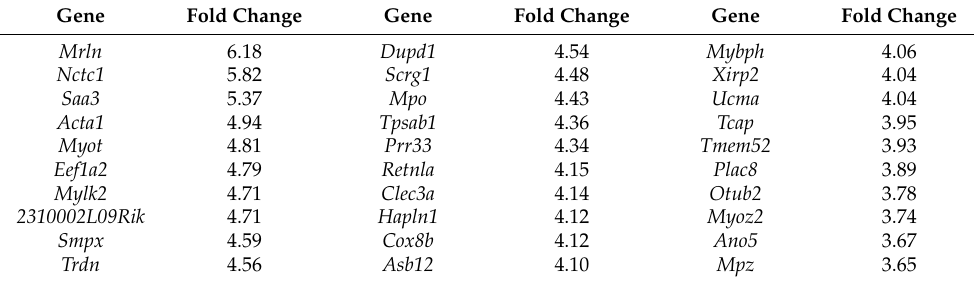
Table 2. Top 30 most regulated overlapping genes in at least two tissues.